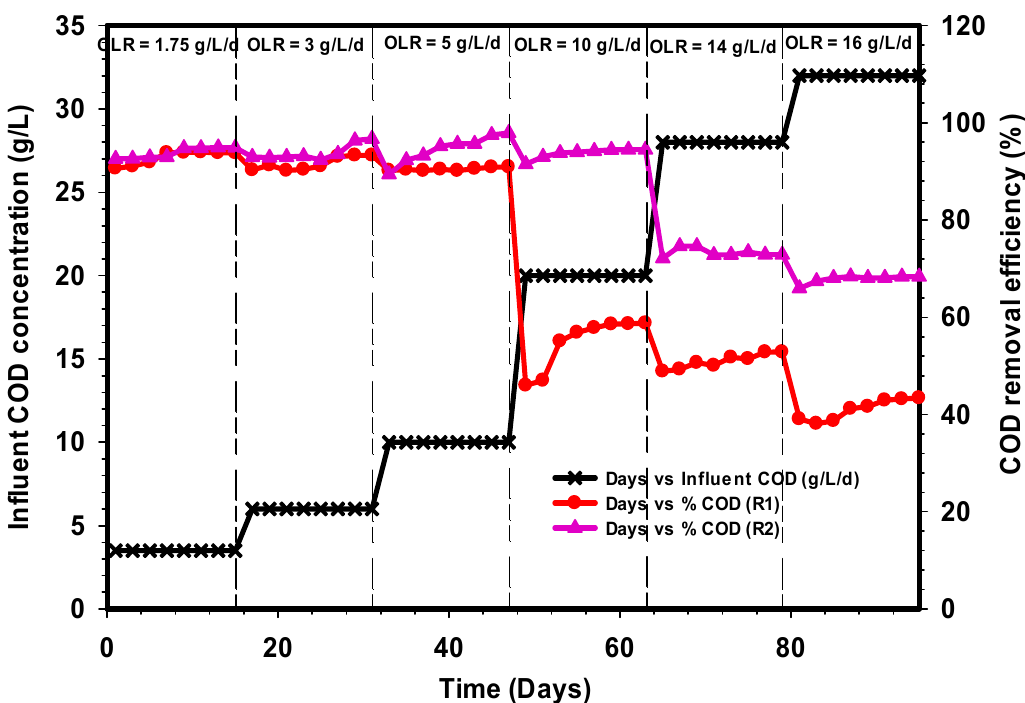
Figure 2. Comparison of chemical oxygen demand (COD) removal efficiencies of R1 and R2.